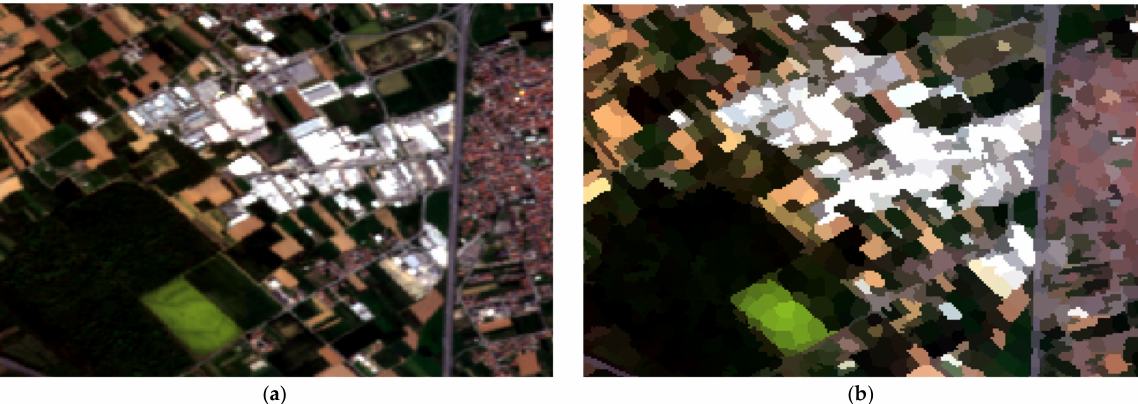
Figure 7. Superpixels segmentation, demonstrated in a 4 km × 3 km site in Lainate, Italy. ( a ) S2 RGB reference ( b ) Average RGB values for the segmented